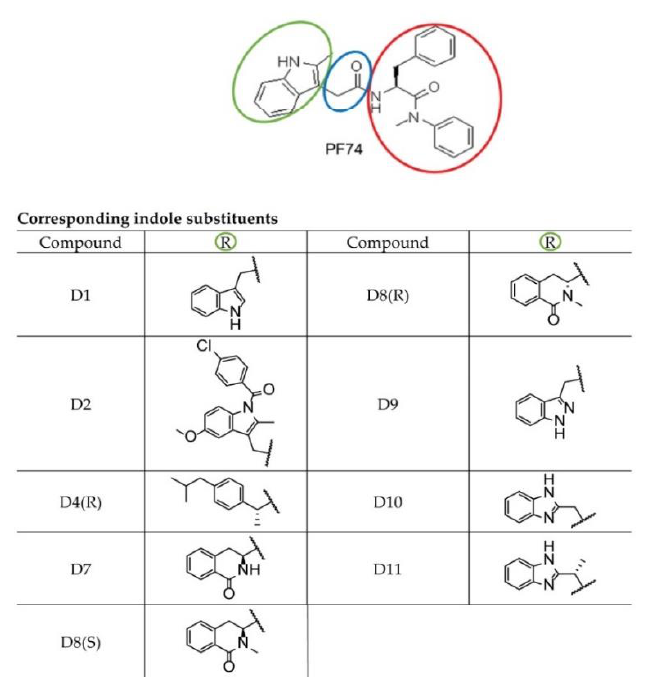
Figure 1. PF74 and its derivatives. Chemical structures of PF74 and its indole derivatives used in this study .